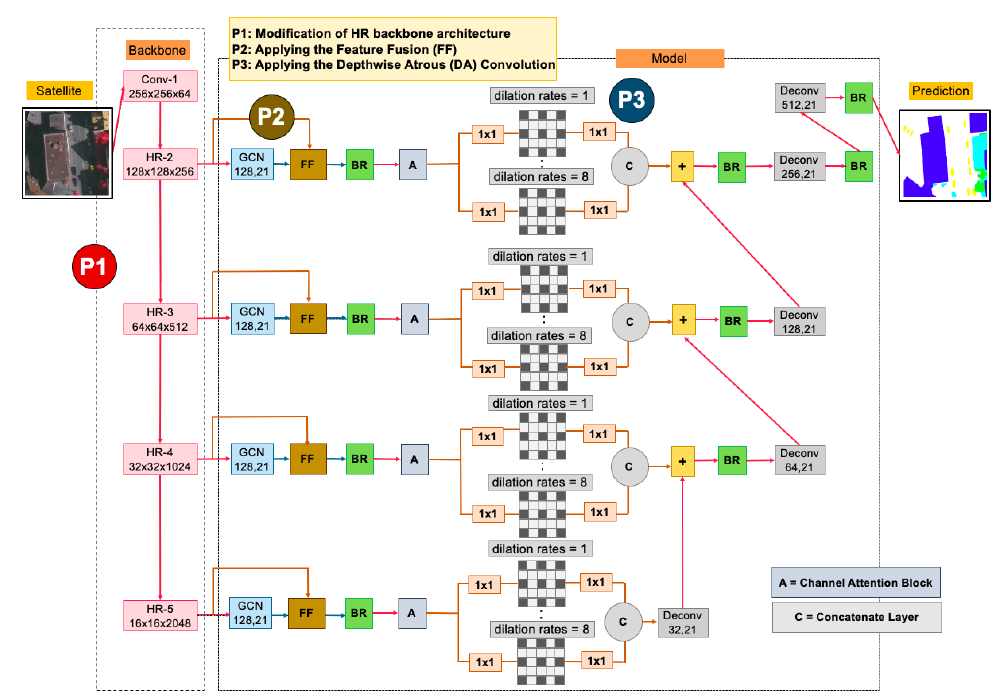
Figure 3. The HR-GCN-FF-DA: an enhanced GCN architecture with feature fusion and depthwise atrous